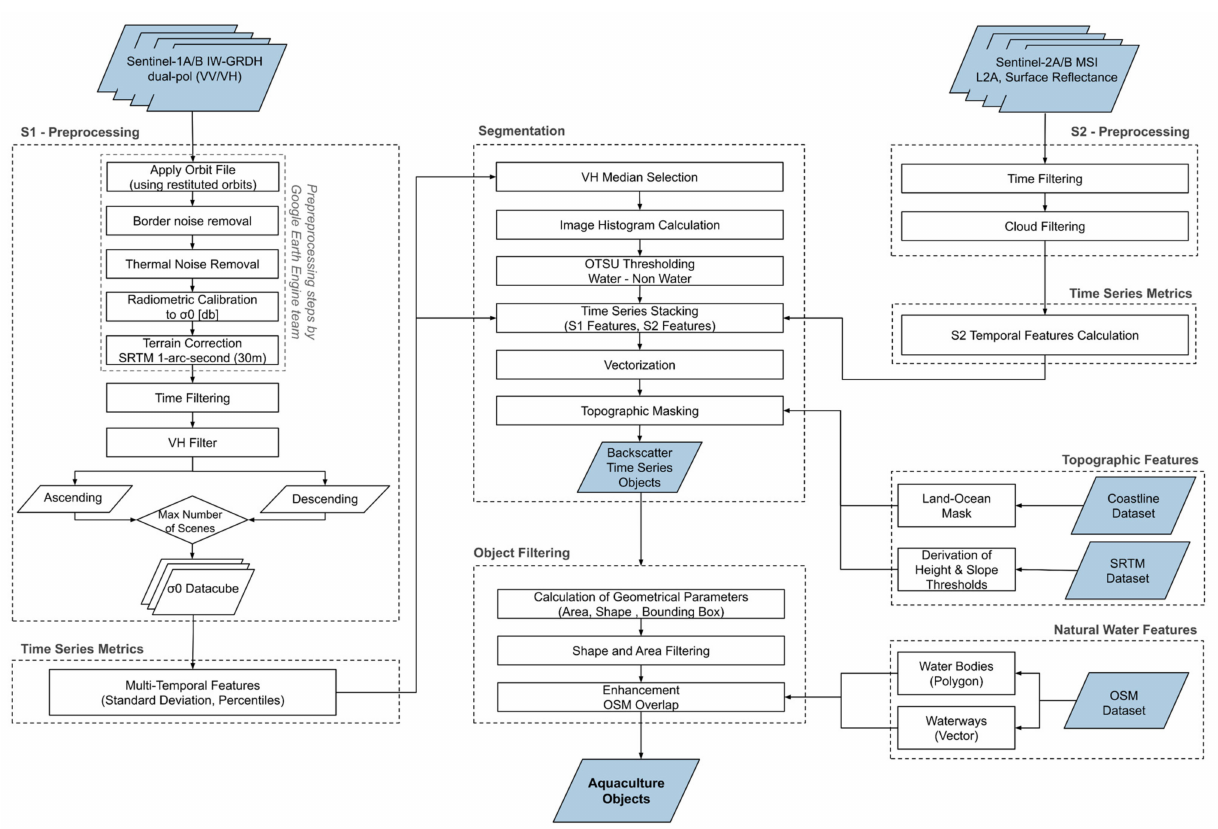
Figure 6. Workflow of the applied method for the mapping of coastal pond aquaculture for Asia, with following main processing blocks: preprocessing of the SAR Sentinel-1 data and optical Sentinel-2 data, generation of time series metrics, image segmentation, masking by topographic features, and object filtering based on geometrical and water